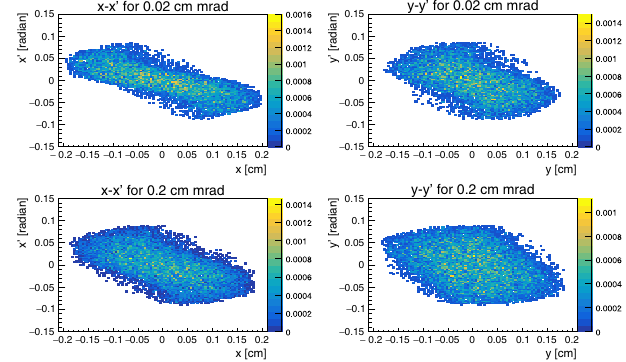
FIG. 7. Scatter plot for the phase space distribution of proton beams at the RFQ entrance. The top two figures correspond to the simulation result with normalized emittance of 0.02 cm mrad, whereas the bottom two figures correspond to that with 0.2 cm mrad. These scatter plots are created by the number of MC events of 10,000 of LEBT beam simulation conducted with RFQGen software and the integrated numbers of them are normalized to FIG. 6. Beam envelope for deuteron in LEBT. be 1. These histograms are divided with 100 × 100 bins.